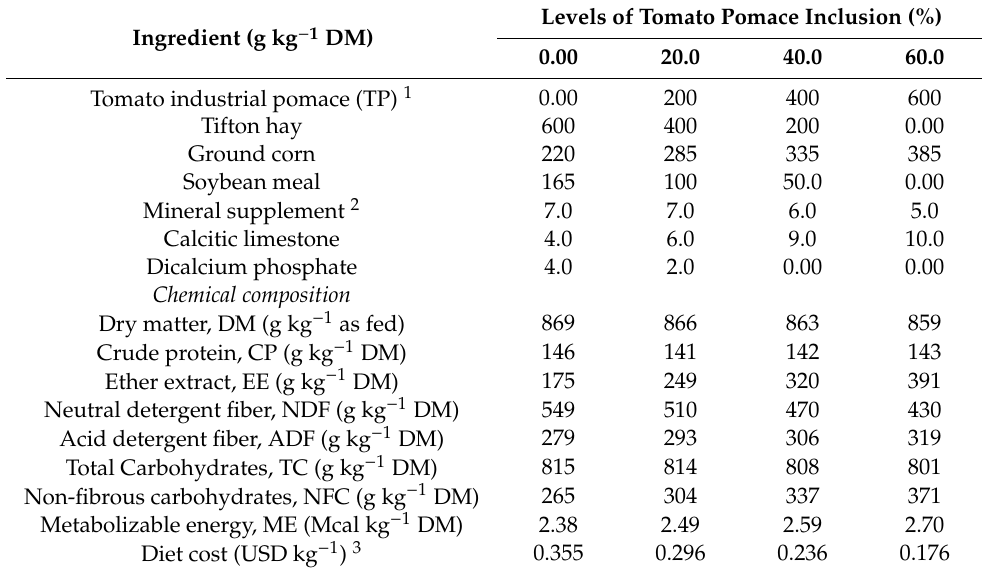
Table 1. Percentage and chemical composition of experimental